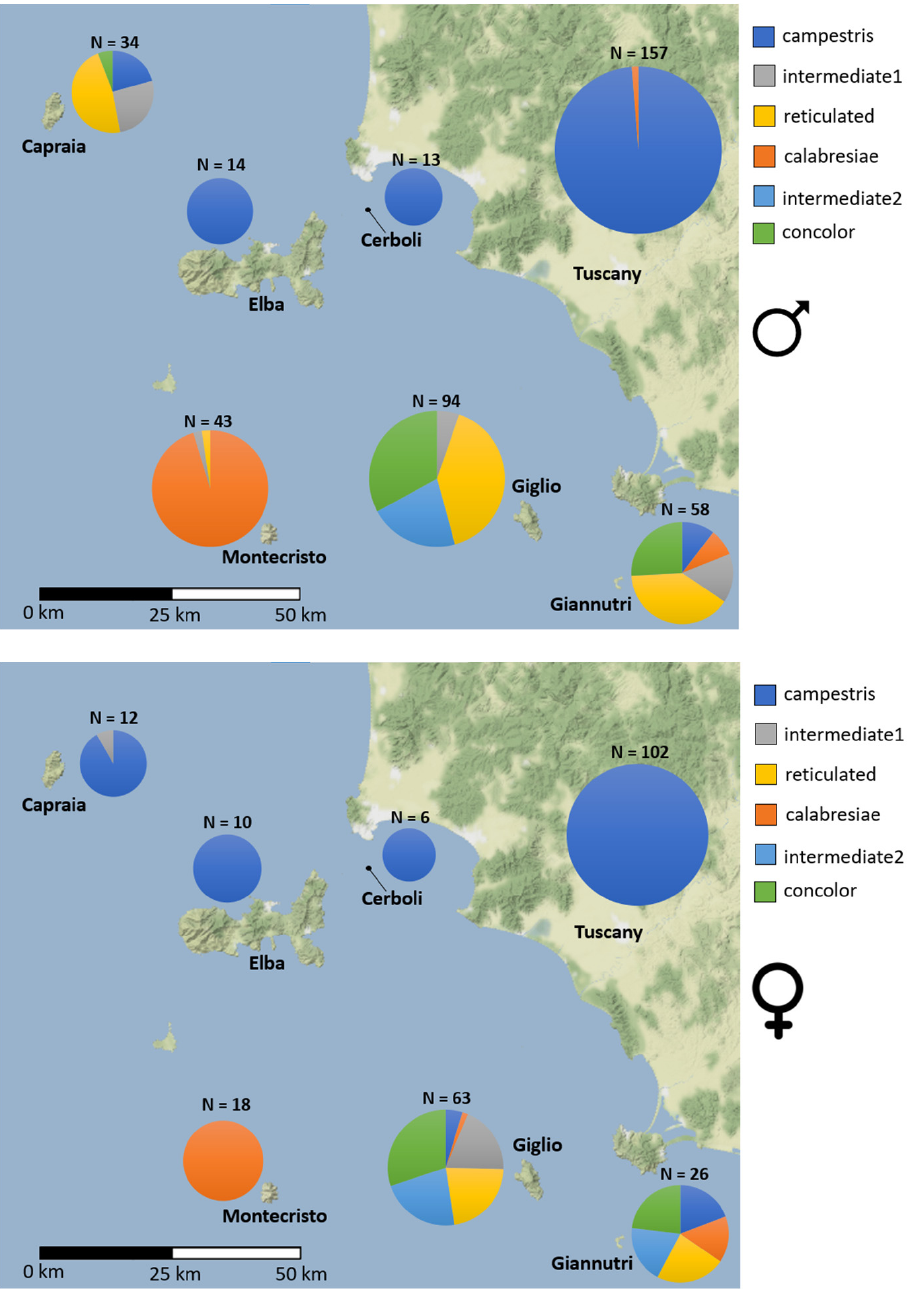
Figure 3. Phenotypic frequencies for males and females in the Tuscan Archipelago and continental Tuscany.